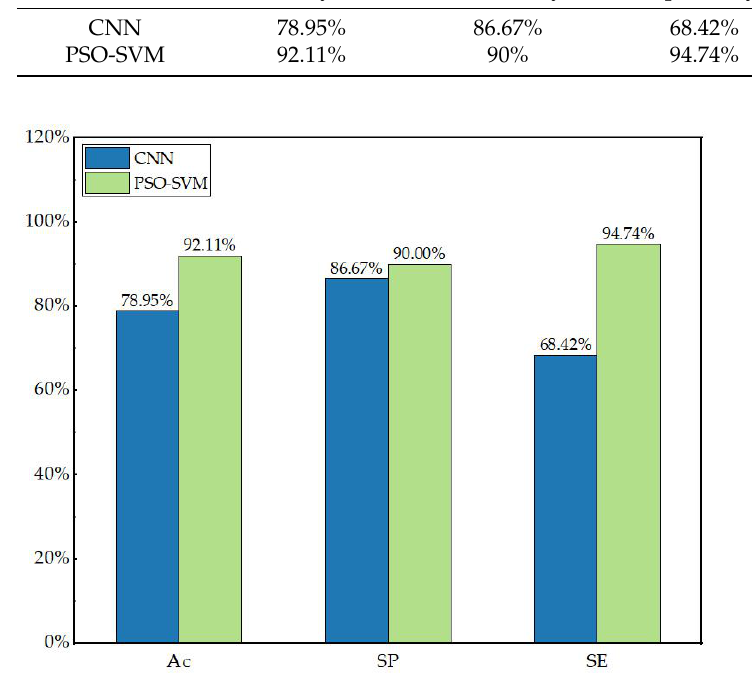
Table 8. Classification results of the test set on different models.